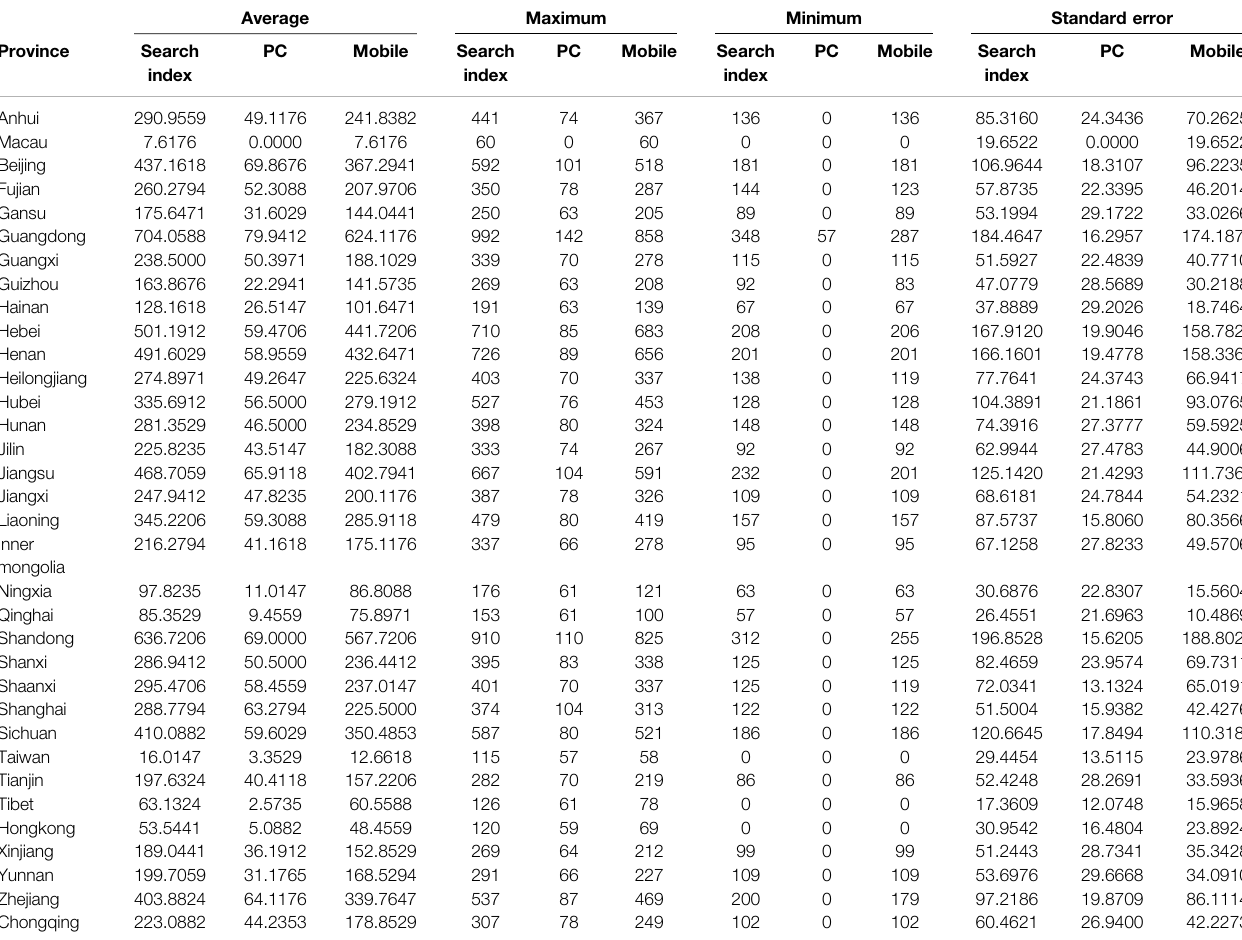
TABLE 1 | Descriptive statistics of Baidu Index of Yoga in